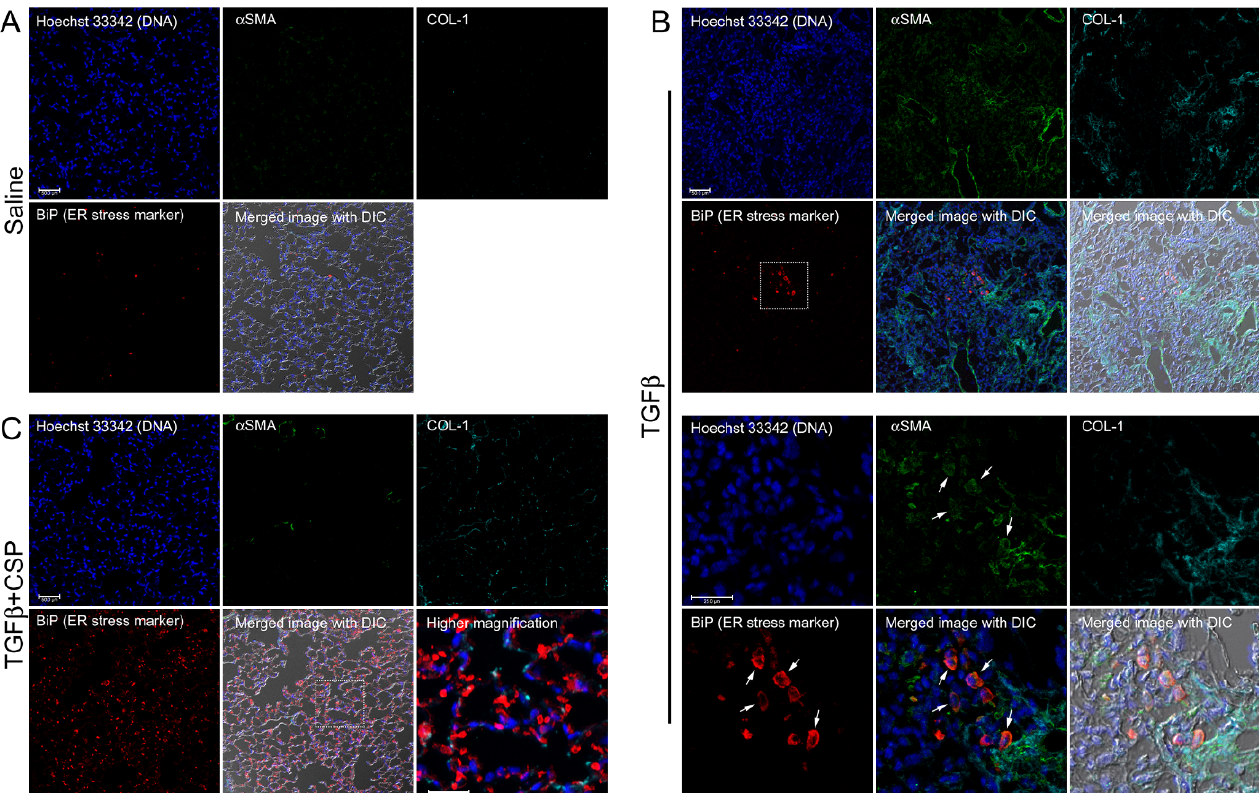
Figure 3. Effect of CSP on ER stress in fibrotic lung fibroblasts in mouse PF lung. Lung sections from mice exposed to ( A ) Saline, ( B ) Ad-TGF β , and ( C ) Ad-TGF β +CSP were stained with DNA (blue), BiP (ER stress marker) (red), collagen 1 (cyan), and α SMA (fibrotic fibroblasts marker) (green). Lower panels in ( B ) show higher magnification images of the upper white boxed area. Arrows show BiP and α SMA double positive cells. Right bottom corner in ( C ) shows a higher magnification image of the white boxed area. Scale bars are 50.0 µm (lower magnification images) and 25.0 µm (higher magnification images), respectively. Images are representative of 10 fields/slide ( n = 3 mice per group).